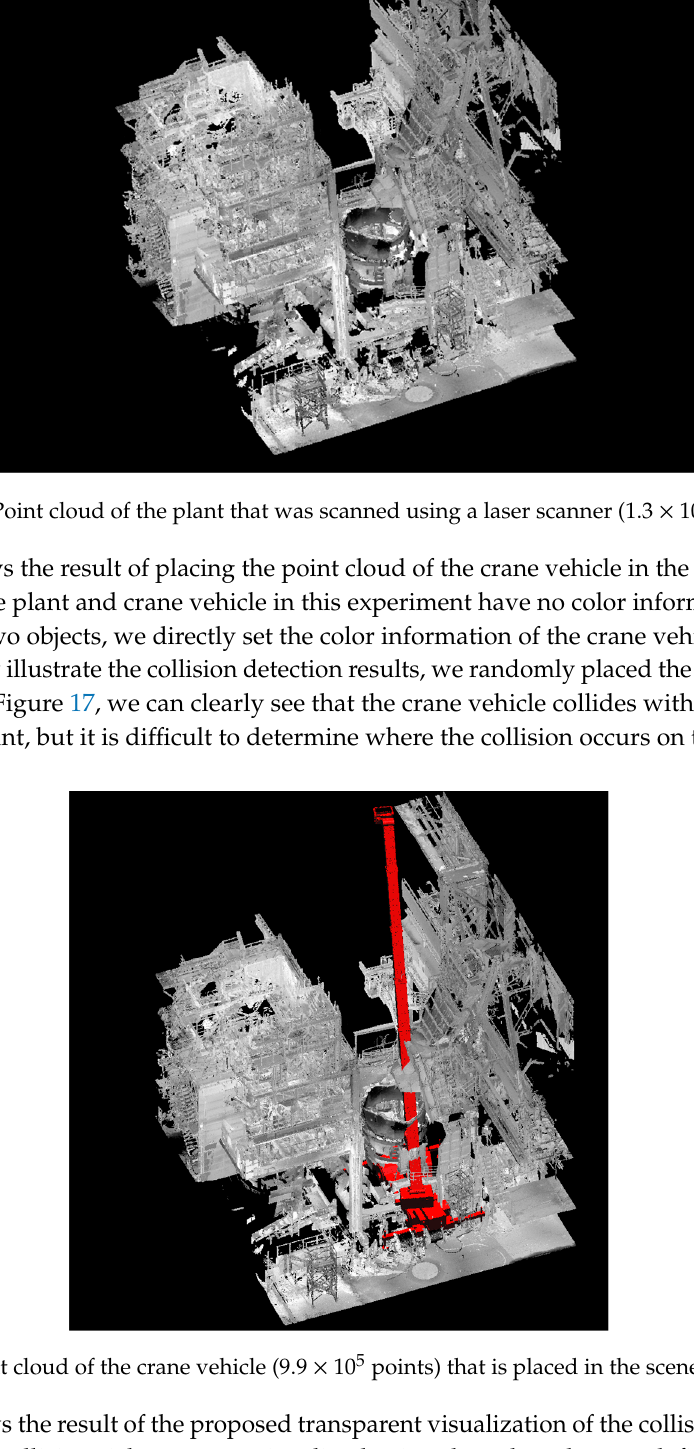
Figure 18. Transparent visualization of the crane vehicle that collides with the plant. The total number of points that is used for the visualization is 1.01 × 10 7 .